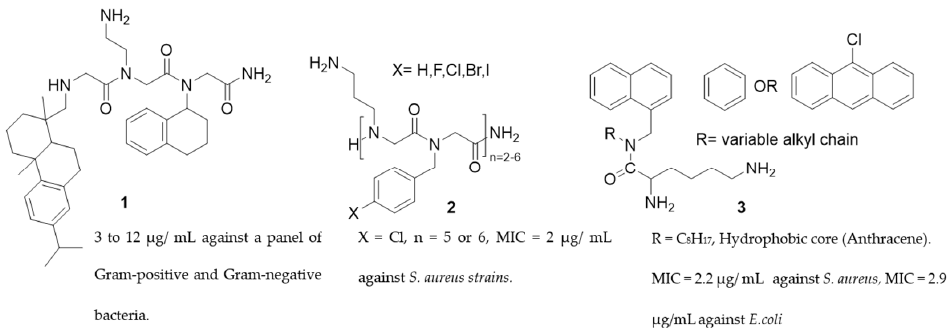
Figure 2. Peptoid mimics that were synthesized by various research groups with the activity of the most active molecules.